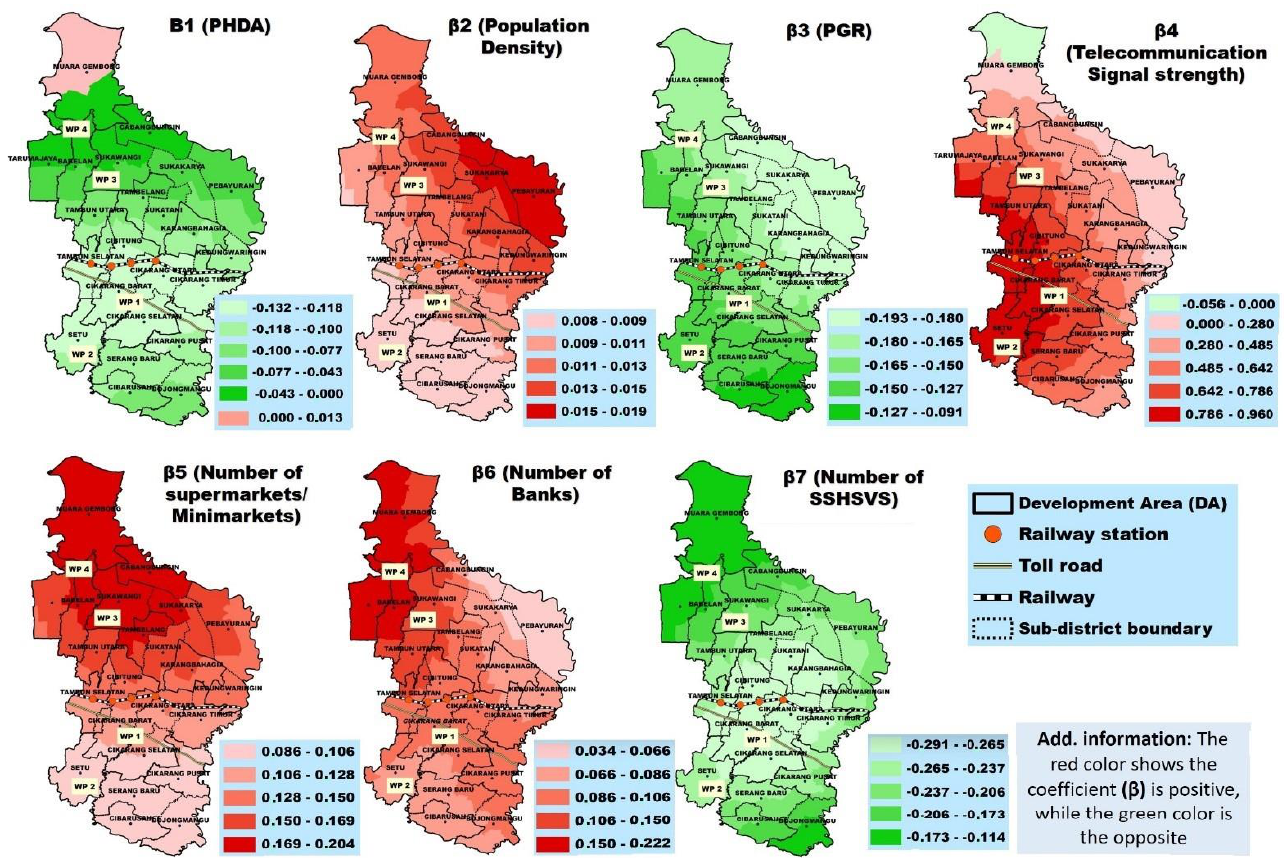
Figure 4. Distribution of the GWR coefficient ( β ) value of each variable for each desa/kelurahan . Table 5. The CV value of each cluster (LPv and HPv) and overall for each zoning